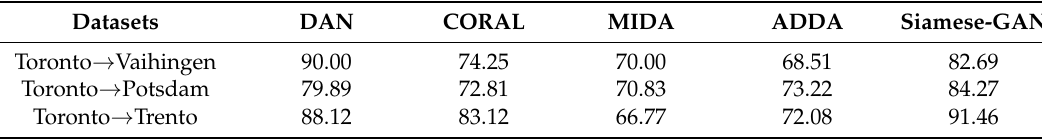
Table 5. Comparison with several state-of-the-art methods. Results are expressed in terms of OA [%] and AA [%] over the 12